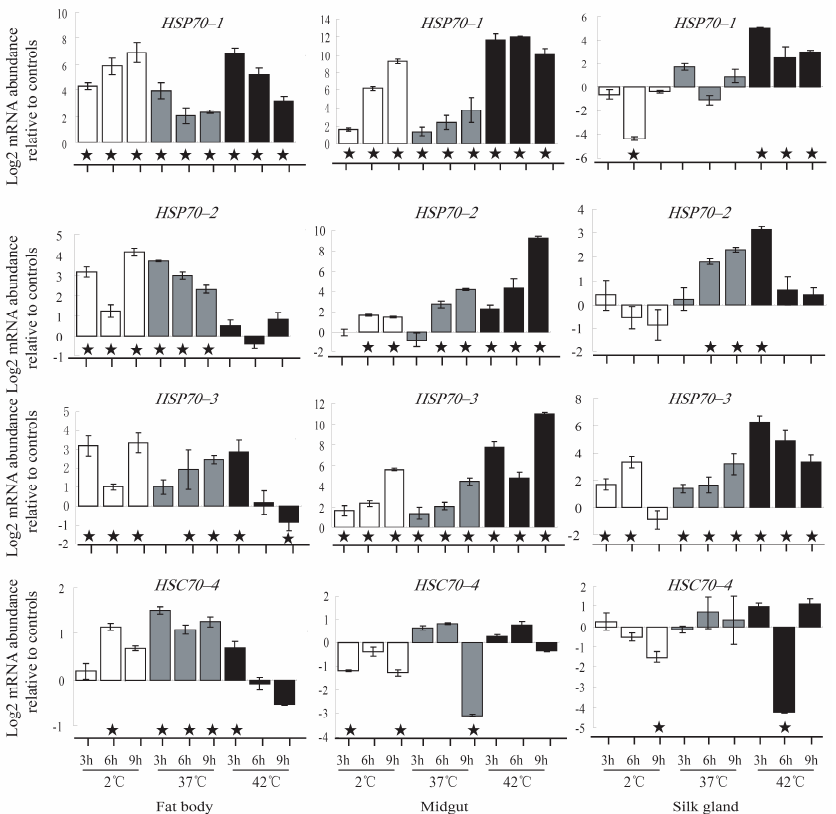
Figure 5. Relative expressions of HSP70–1, HSP70–2 , HSP70–3 , and HSC70–4 in the silkworm after exposure to cold and thermal stresses. It was indicated by Log 2 qPCR ratios (i.e., Log 2 mRNA abun- dance relative controls). The symbol ( ★ ) indicates mean values that are significantly ( p < 0.05) dif- ferent between a treated sample and its corresponding control. The positive and negative values indicate up-regulation and down-regulation in the treatment, respectively. After exposure to cold stress, the expressions of HSP70–1 , HSP70–2 , and HSP70–3 were also induced (Figures 4 and 5). In the fat body and midgut, HSP70–1 was the most